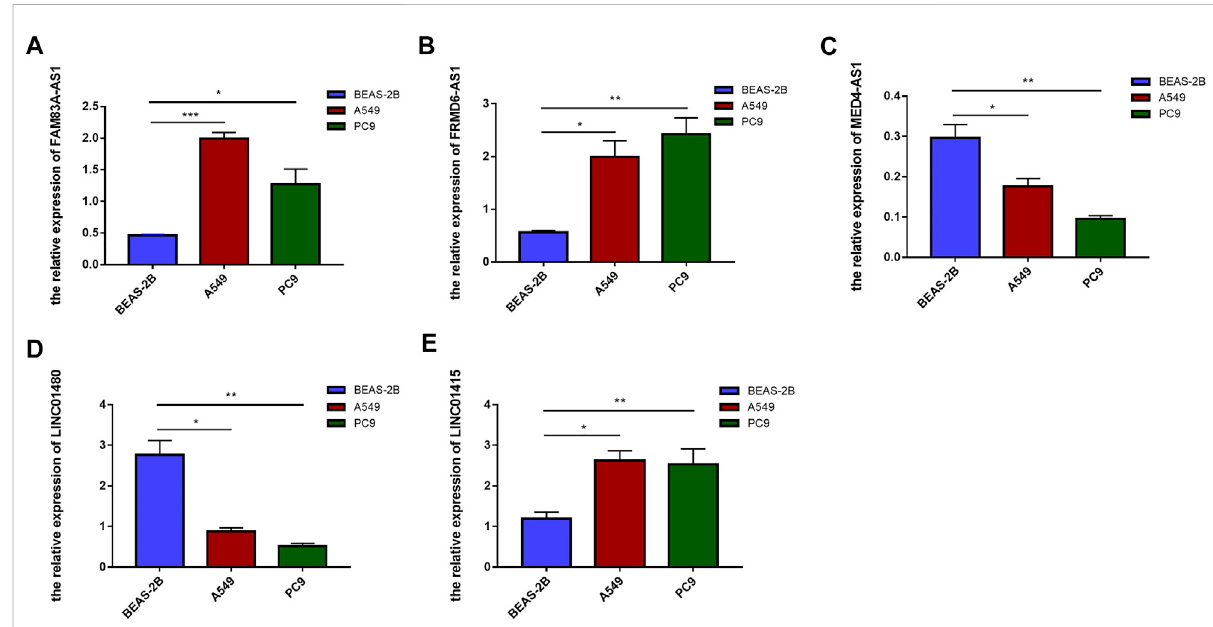
FIGURE 11 The expression level of six NRlncRNAs in BEAS-2B, A549, and PC9 cell lines. Expression of FAM83A-AS1 (A) , FRMD6-AS1 (B) , MED4-AS1 (C) , LINC01480 (D) , and LINC01415 (E) in normal lung epithelial cells (BEAS-2B) and lung adenocarcinoma cells (A549/PC9) detected by RT-qPCR. * p < 0.05, ** p < 0.01, *** p <